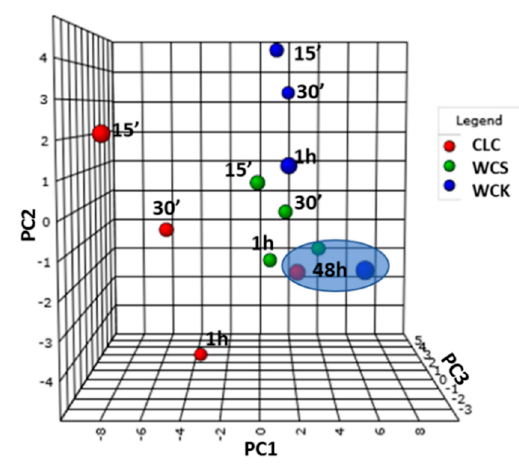
Figure 7. 3D PCA scores plot of mercerization at 80 °C.